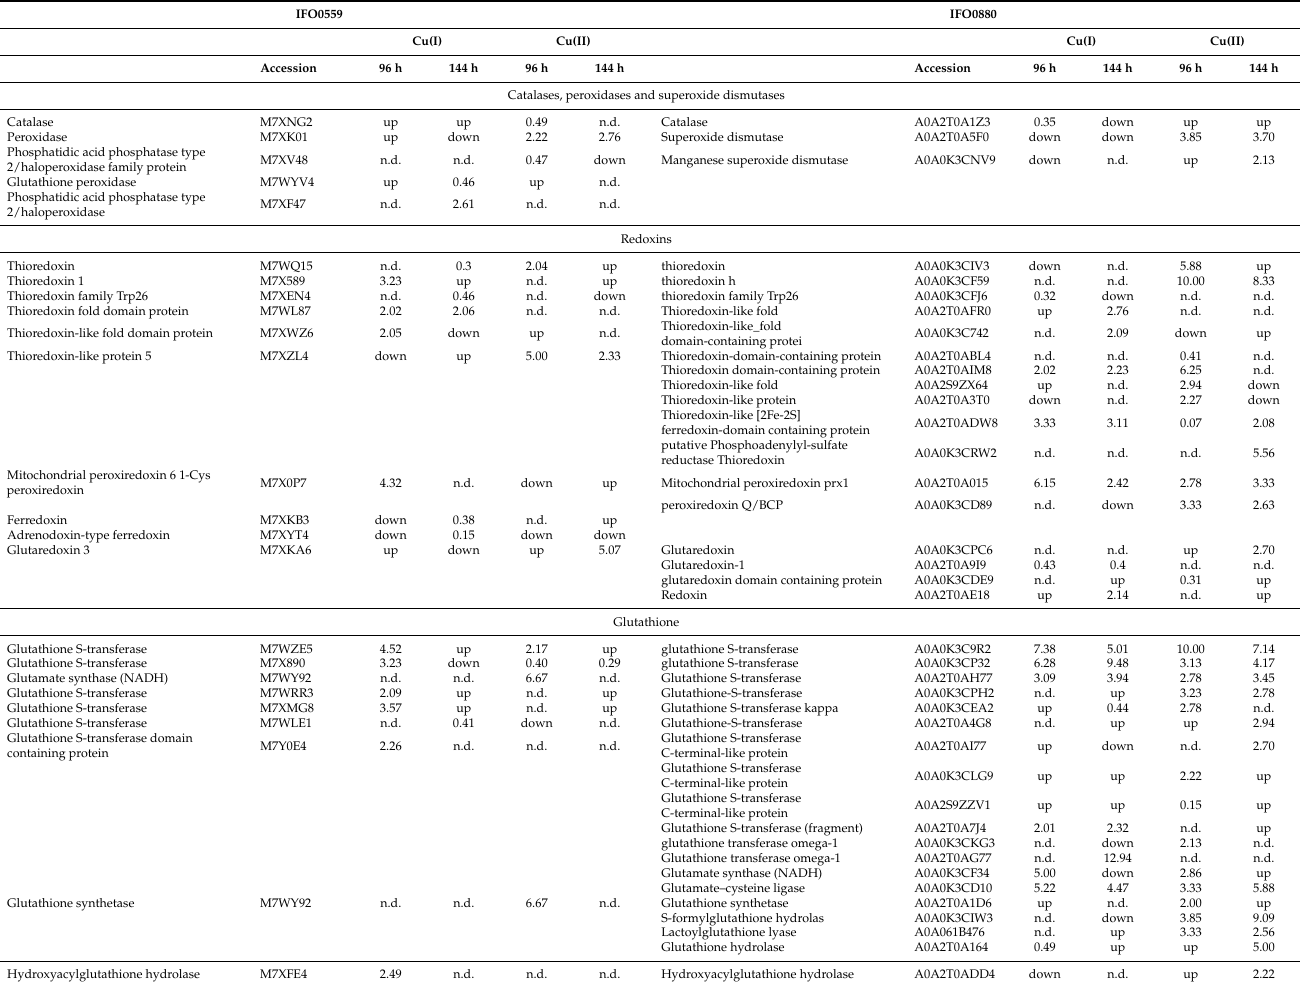
Table 1. Differentially expressed proteins involved in oxidative stress discussed here. For IFO0559 and IFO0880, fold change of samples grown under Cu(I) and Cu(II) stress was compared to respective control. Protein name and UniProt accession numbers are listed. Further fold changes at 96 h and 144 h of samples are stated. Fractions below 1 depict downregulation. n.d. = not detected; up = upregulated below cut-off score; down = downregulated below cut-off score. Cut-off score: significance ≤ 2 or fold change ≤ 2.